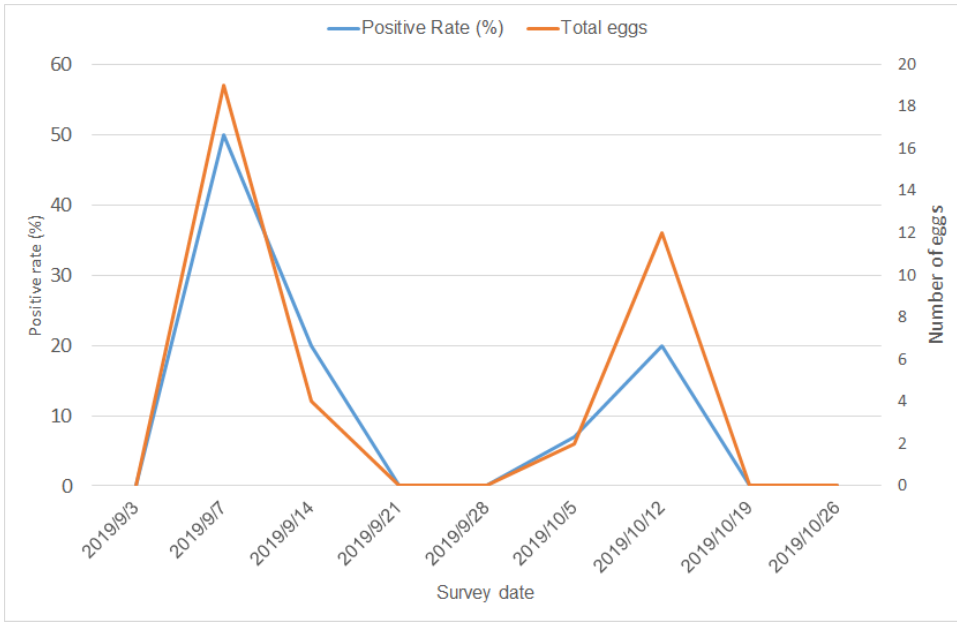
Figure 3. Temporal pattern of positive rates and number of eggs in ovitraps at the mountain trail.